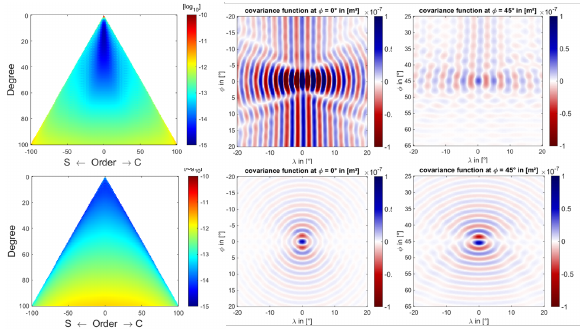
Fig. 4. Formal error triangle plots in log 10 (left), and spatial covari- ance functions (middle column for equator, right column for 45 ◦ latitude) for GRACE type (top row), and MOBILE constellation (bot- tom